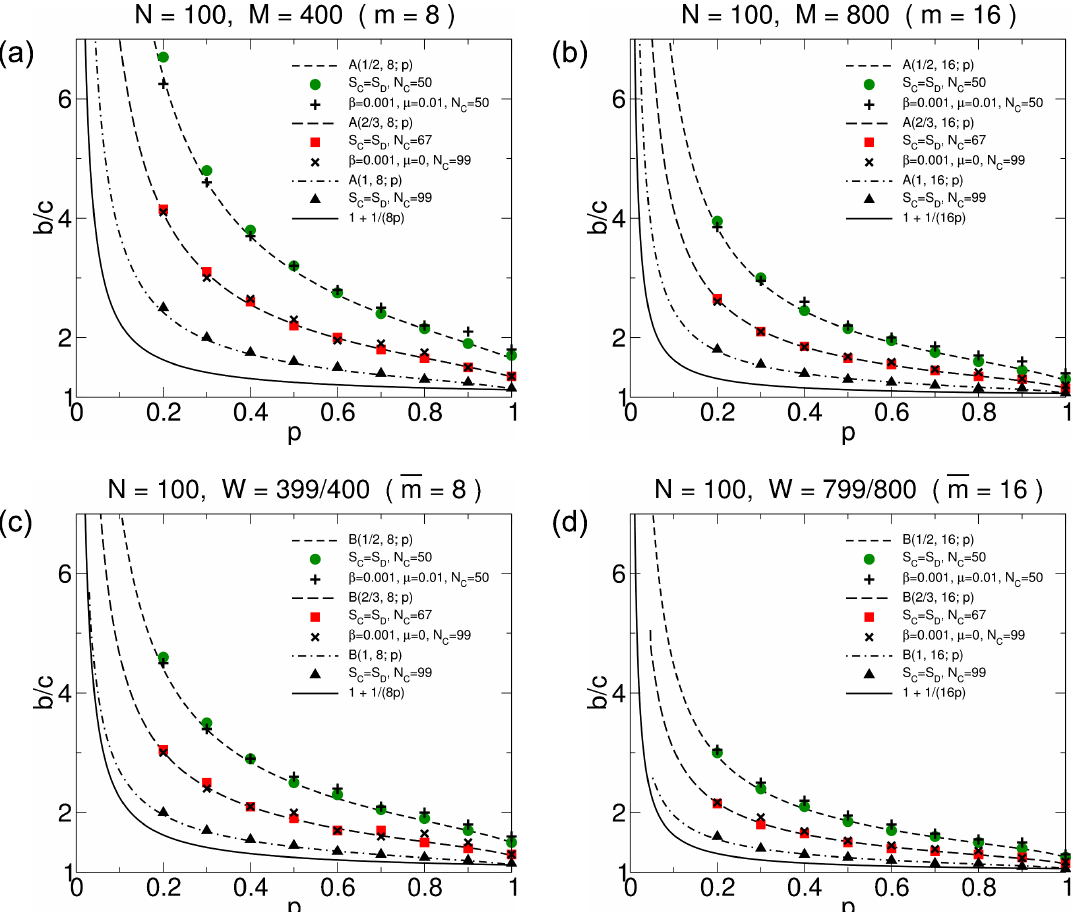
Figure 4. The critical value of b/c for cooperation to be favored over defection in various